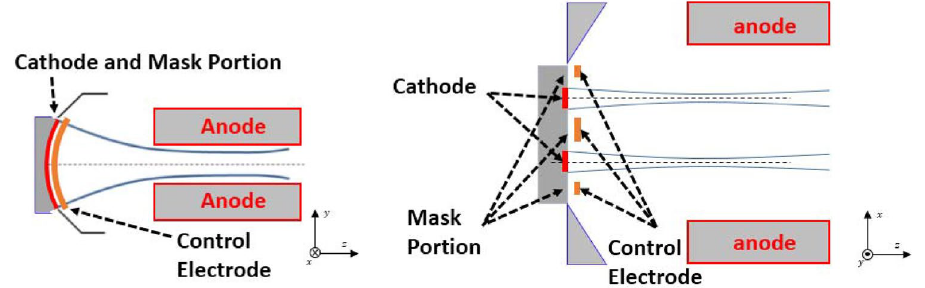
Figure 5. Schematic of the planar double-beam electron gun in both two transverse directions.